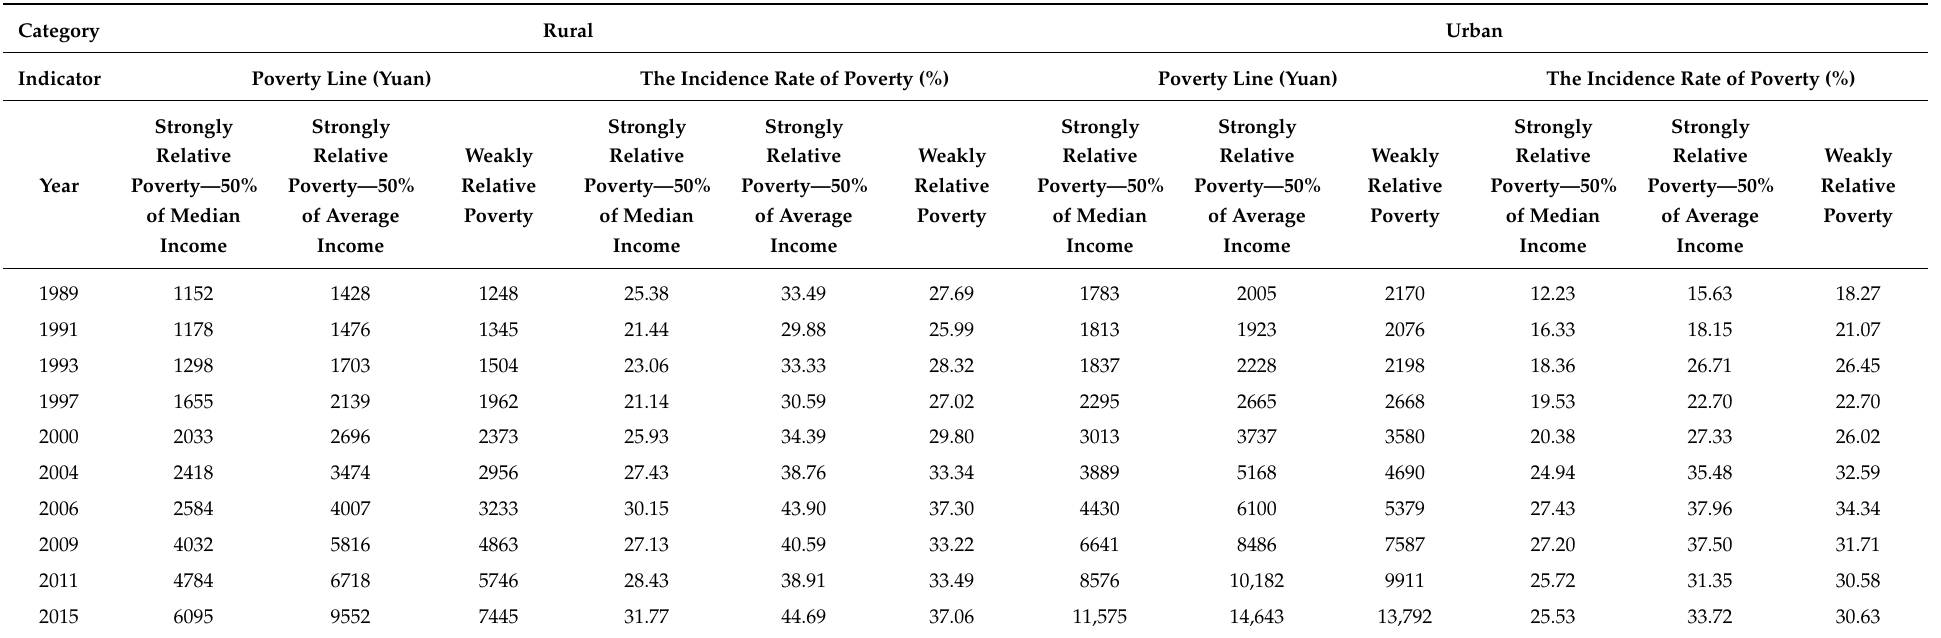
Table 4. Relative poverty between urban and rural